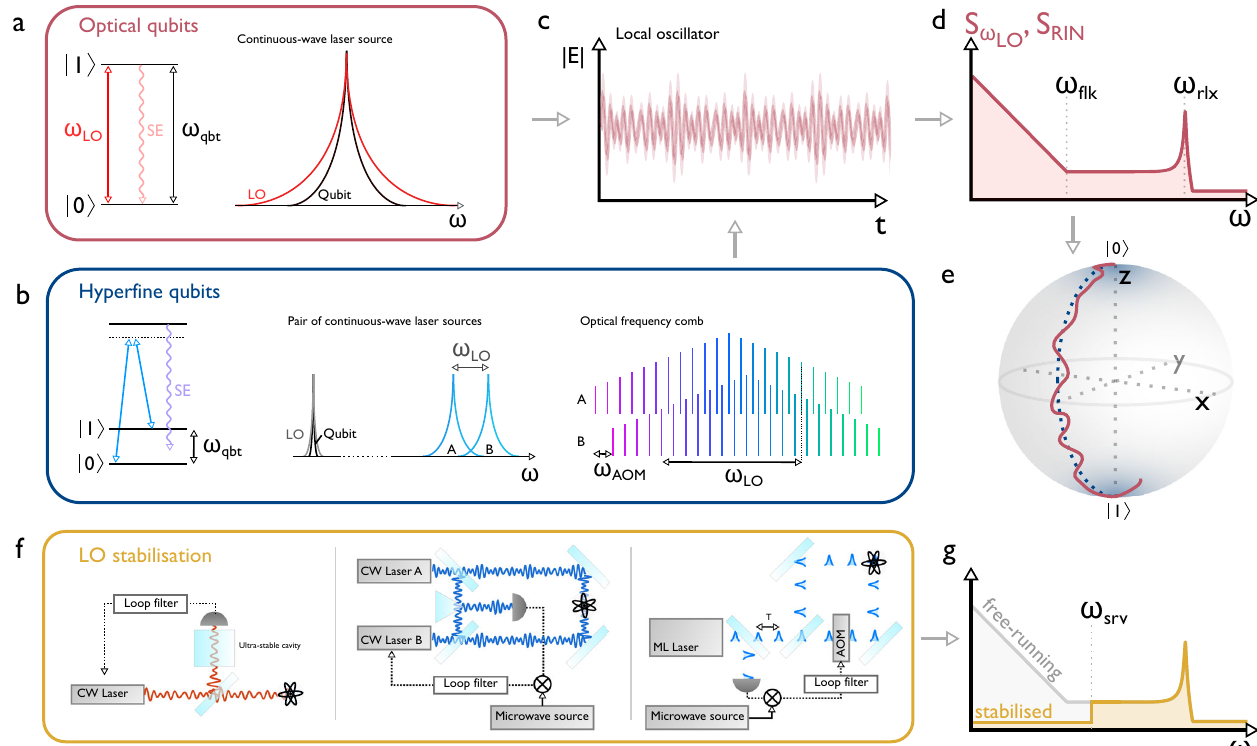
Fig. 1 Atomic qubit control using lasers as the local oscillator (LO). a For optical qubits, the laser light is resonant with the qubit transition. b For hyper fi ne qubits, the LO is derived from the beatnote between two closely spaced optical frequencies. For continuous-wave (CW) lasers, this is performed by off-set phase locking two lasers by the qubit frequency. For modelocked (ML) lasers, this is performed by interfering two frequency combs at the atom position, with one comb shifted in frequency such that the qubit is driven by the frequency difference between comb pairs. c Noise away from the laser carrier frequency leads to a time-dependent variation in the LO control fi eld, which can itself be expressed as a power spectral density, as shown in ( d ). e The time-dependent noise causes perturbations in qubit evolution on the Bloch sphere. f Example servo loops for stabilising laser frequency noise. g The servo loops act to reduce noise within the servo bandwidth, while free-running noise at higher frequencies is